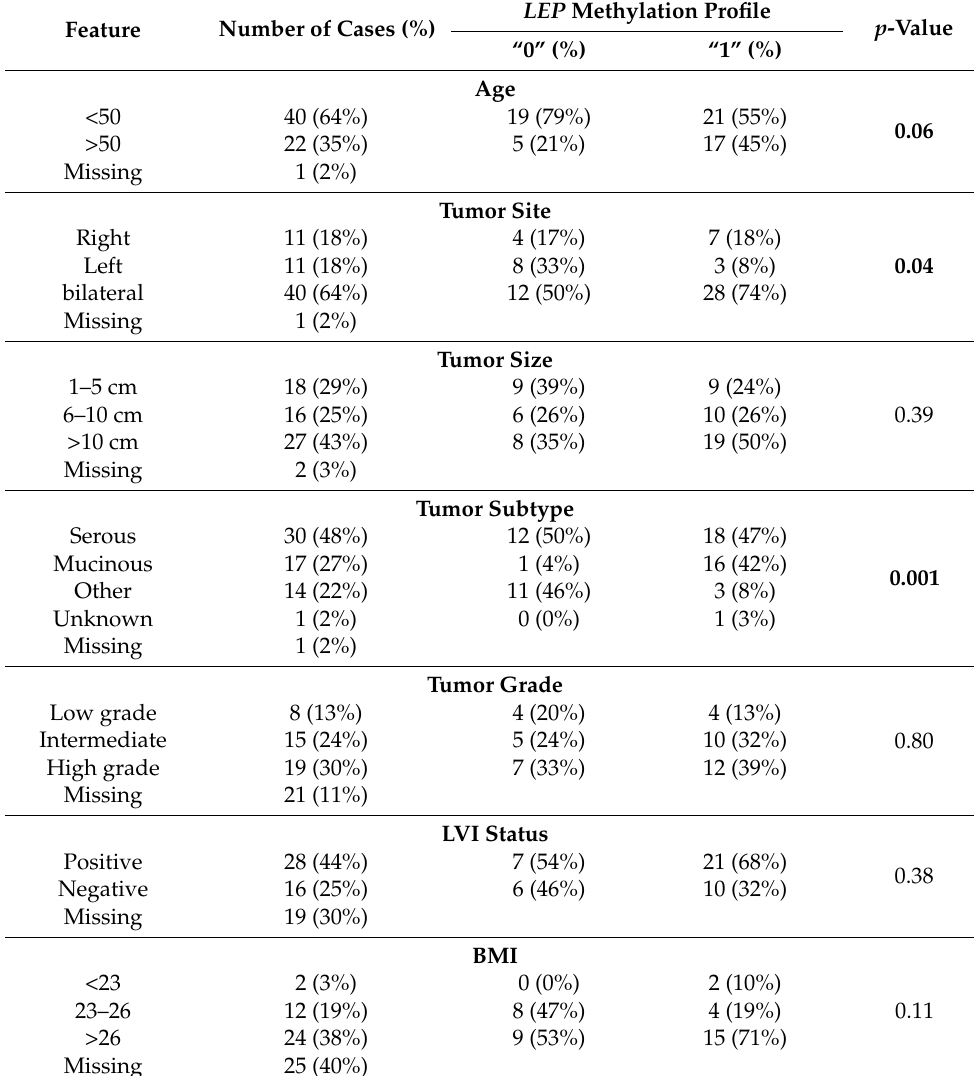
Table 2. Correlation between LEP methylation profile and clinicopathological features of OC